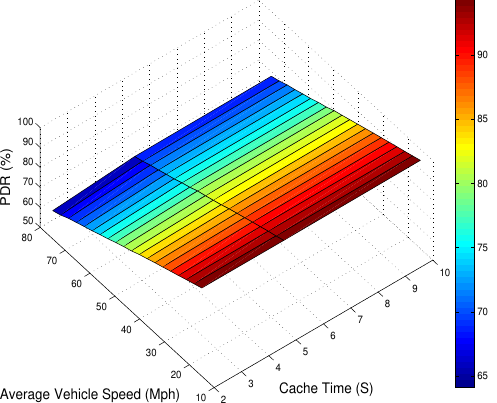
Figure 6. Packet delivery ratio vs. 2 s, 5 s, 10 s Cache Time and Average Vehicle Speed (Mph).